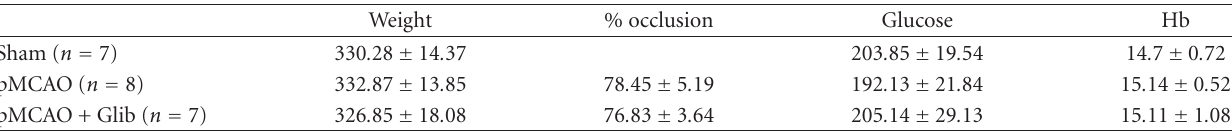
Table 1: Physiological variables: Using a SurgiVet pulse oximeter, blood SPO 2 was monitored and maintained at levels greater than or equal to 90%. Body temperature was monitored throughout surgery by rectal probe and maintained at 37 ◦ C using a homeothermic heat lamp temperature